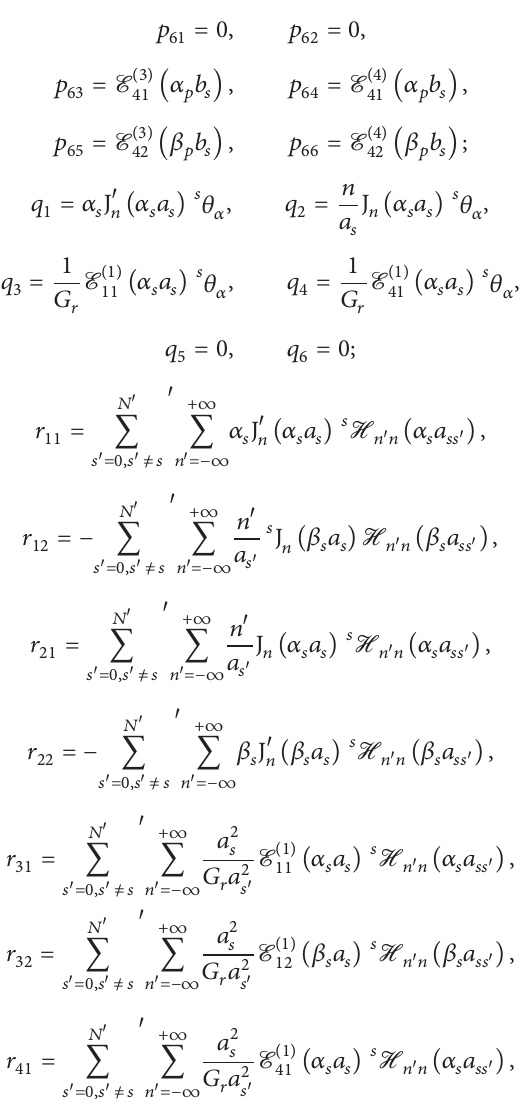
Figure 14: Contours of normalized displacement amplitudes by double-rows of tubular piles (rectangular arrangement, 𝑏 𝑠 = 0.9𝑎 𝑠 , 𝑠 𝑝 = 6.0𝑎 𝑠 , 𝐺 = 10 , 𝑚 = 4 , 𝑁 = 8 ℎ = 3.0𝑎 𝑠 , 𝑟